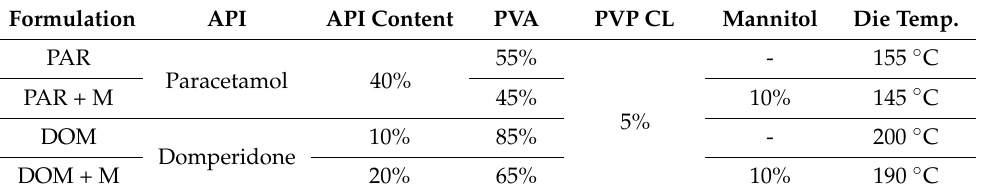
Table 1. The composition and extrusion temperature of filaments.